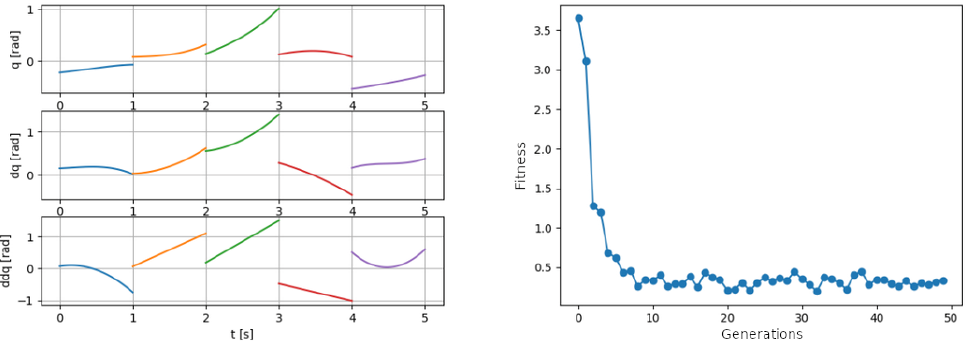
Figure 12. The achieved results for the GA with 1000 candidate solutions trained for 50 generations. The best-achieved solution is visualized on the ( left ), and the fitness change through generations is on the ( right ).